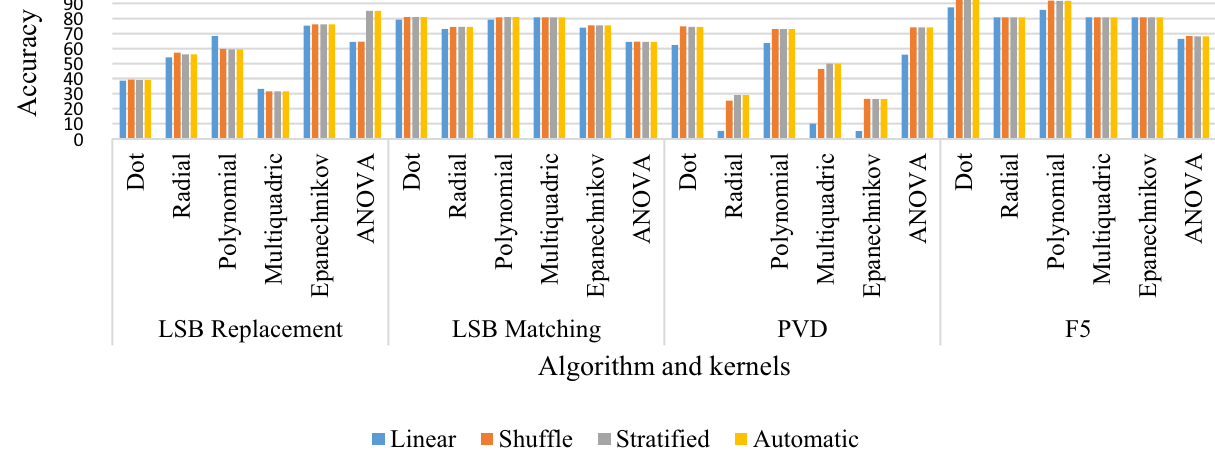
Graph 5. Result of classification of uncalibrated images with cross-validation using SVM for random